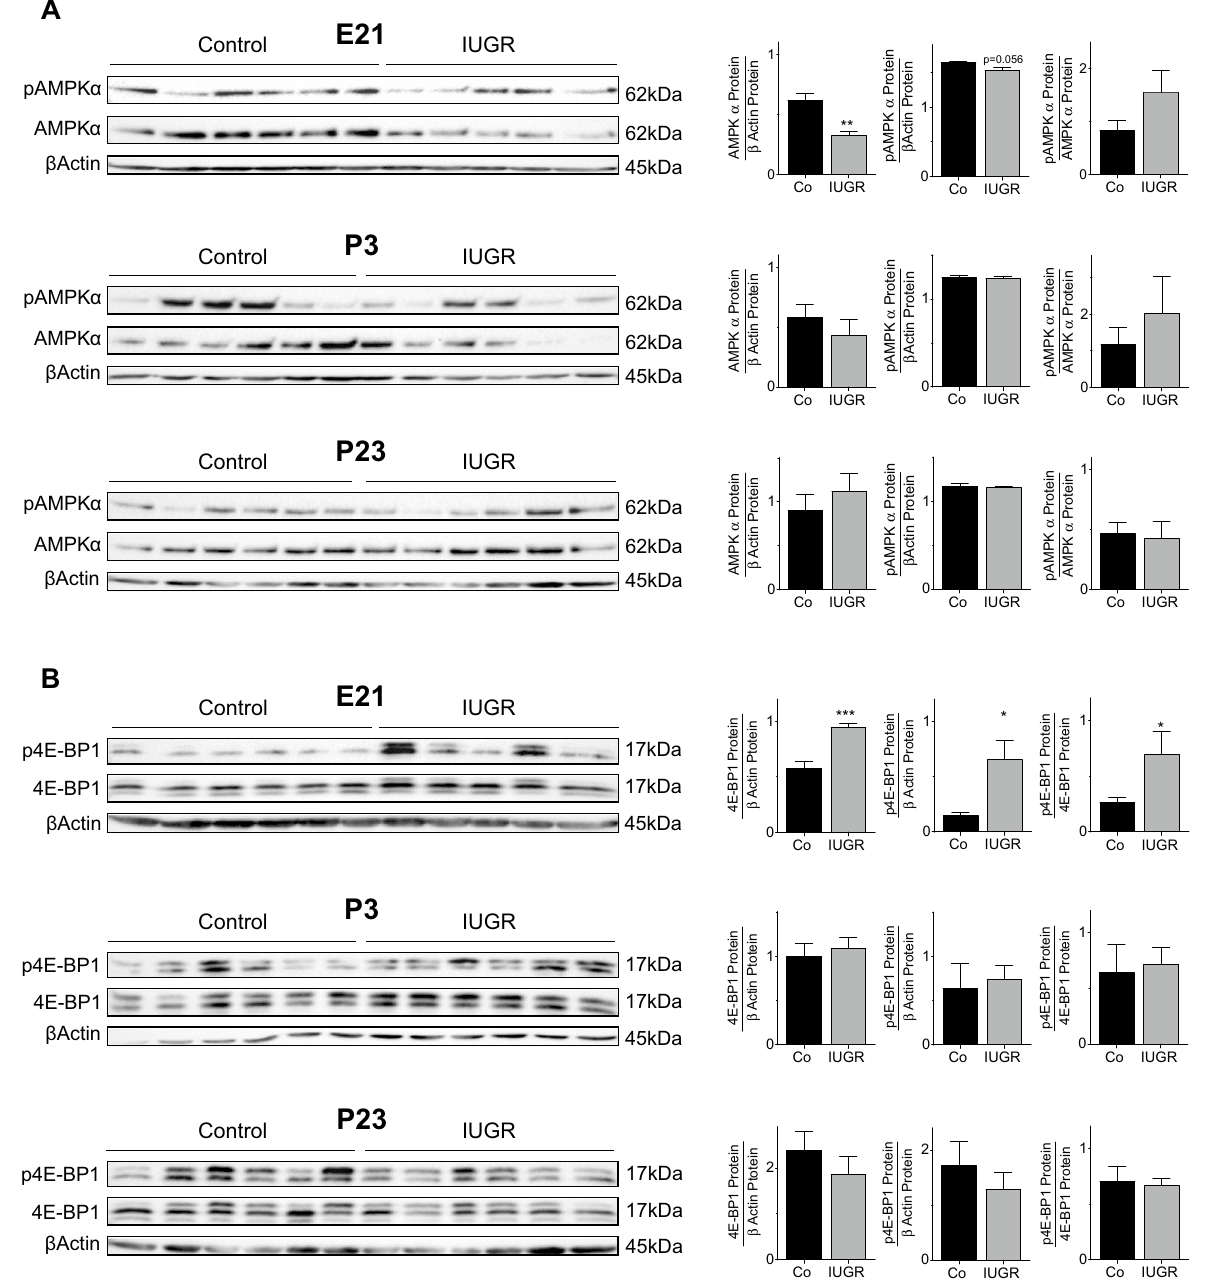
Figure 5. IUGR dysregulates nutrient-sensing signaling pathways that are involved in angiogenesis. ( A ) Immunoblots showing the analysis of AMP-Activated protein kinase (AMPK)α-pathway in total lung homogenate on embryonic day (E21), postnatal day 3 (P3), and P23; total AMPKα and phosphorylated AMPKα (pAMPKα) were assessed; βActin served as loading control; pAMPKα was related to β-Actin or to total AMPKα; densitometric summary data are shown next to the respective immunoblot (n = 6/group). ( B ) Total 4E-BP1 and phosphorylated 4E-BP1 (p4E-BP1) as a downstream effector of mTOR-pathway were assessed with immunoblot on E21, P3, and P23; βActin served as loading control; p4E-BP1 was related to βActin or to total 4E-BP1; densitometric summary data are shown next to the respective immunoblot (n = 6/group). Mean ± SEM. A non-parametric T-test was used to compare IUGR to the Control group, *p < 0.05, **p < 0.01, ***p <